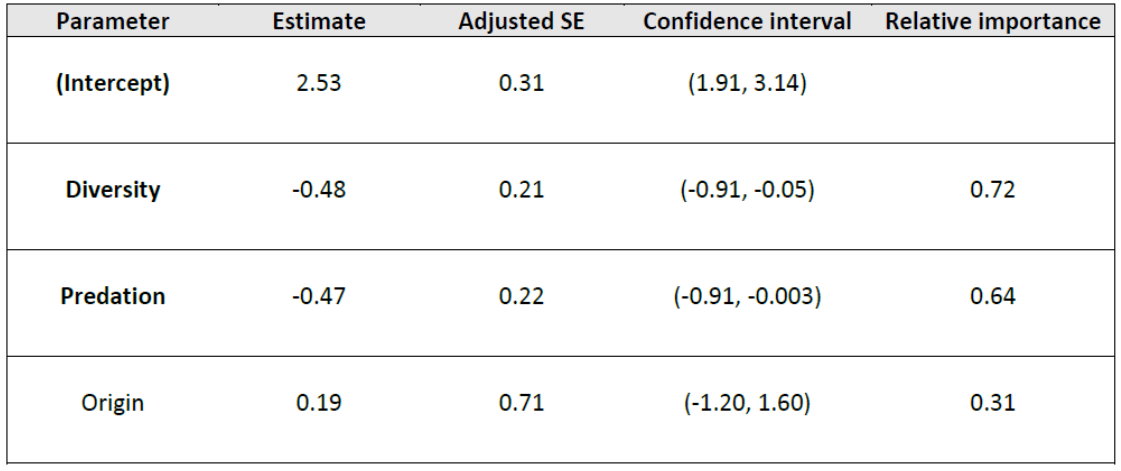
Table 3. Summary results after model averaging: effects of each parameter presents on the set of best models on herbivory rate. Bold parameter are significant. Relative importance is a measure of the prevalence of each parameter in each model used in model